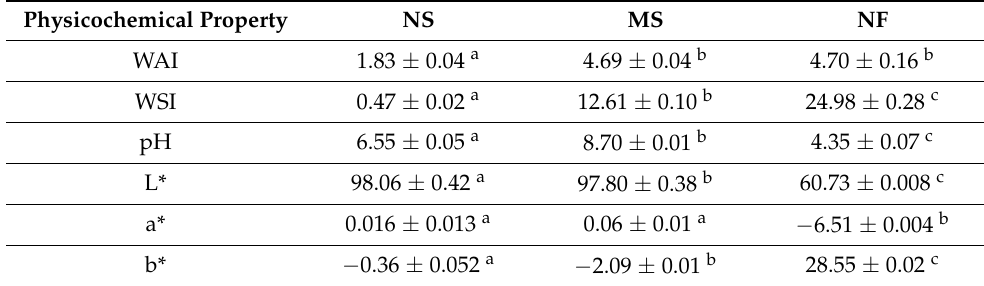
Table 2. Physicochemical properties of native rice starch, modified by extrusion and nopal